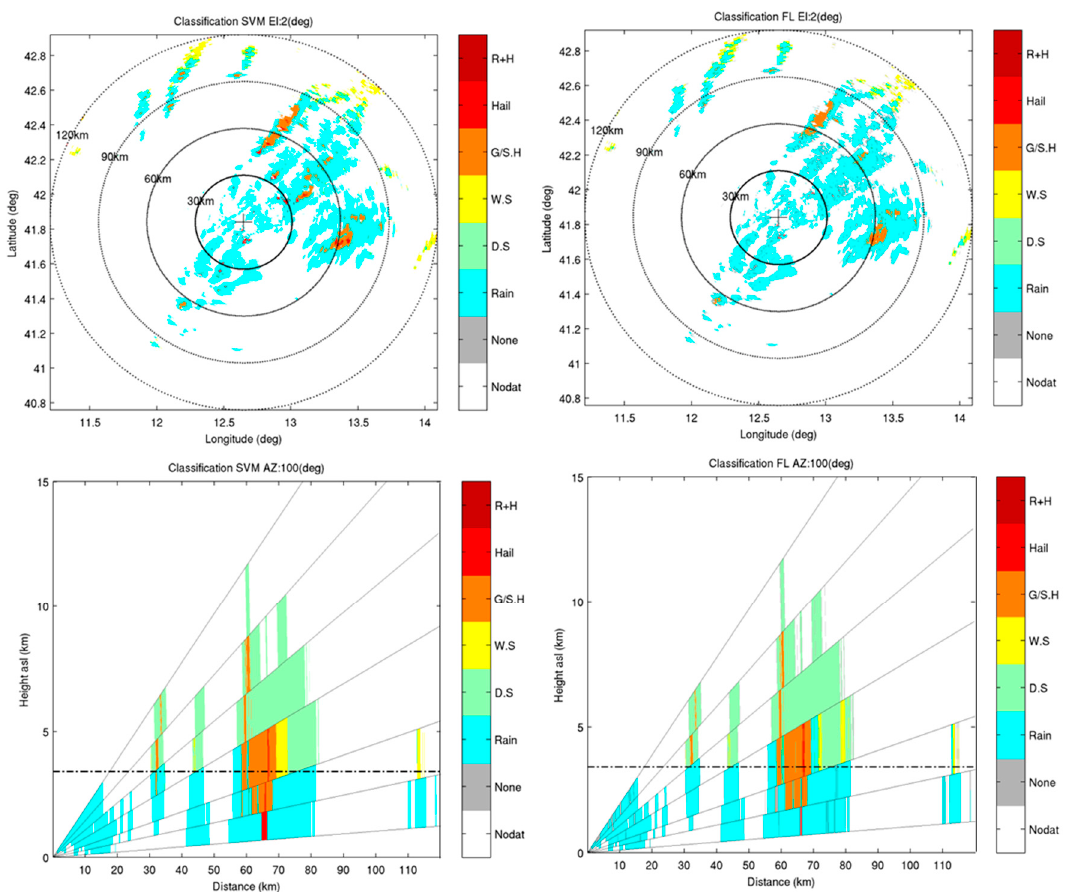
Figure 3. Hydrometeor classification applied to the volume collected on15 October 2012 at 1016 UTC by the Polar 55C radar. Left column: Support Vector Machine (SVM) approach results; Right column: FL approach results. Upper panels show the Plane Position Indicator (PPI) at 1.6° and the bottom panels show the pseudo Range Height Indicator (RHI) at 100° azimuth. In the legend of this and of the following figures “R+H” stands for hail mix ; “G/S:H” stands for graupel ; “WS” stands for wet snow ; “DS” stands for dry snow ; “none” stands for not classified ; “nodat” stands for no data .